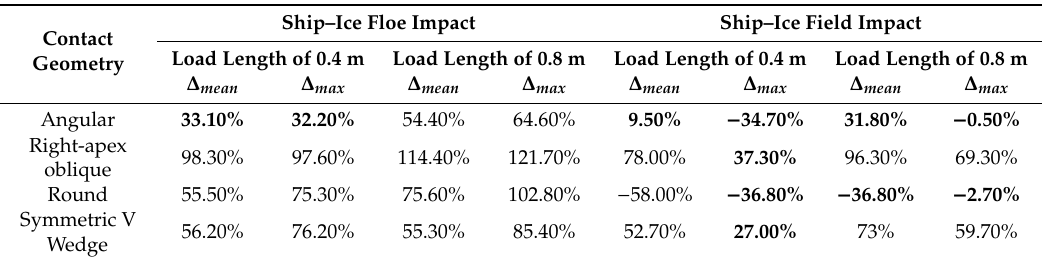
Table 3. Percentage-deviations between loads calculated for various collision scenario assumptions and the measured values of data set A. (Bold font indicates that the deviation is below ± 40%.) Contact Geometry